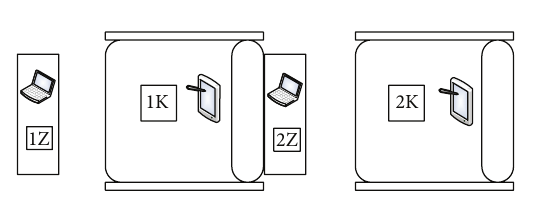
Figure 2: Renumbered rows.